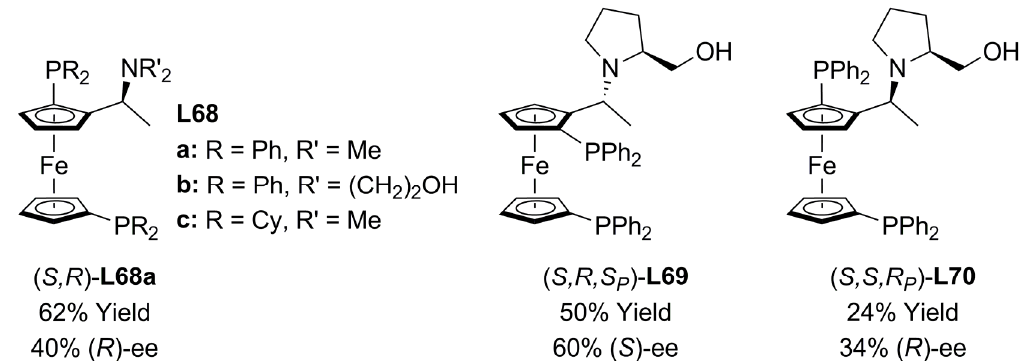
Figure 25. Ferrocenylamine